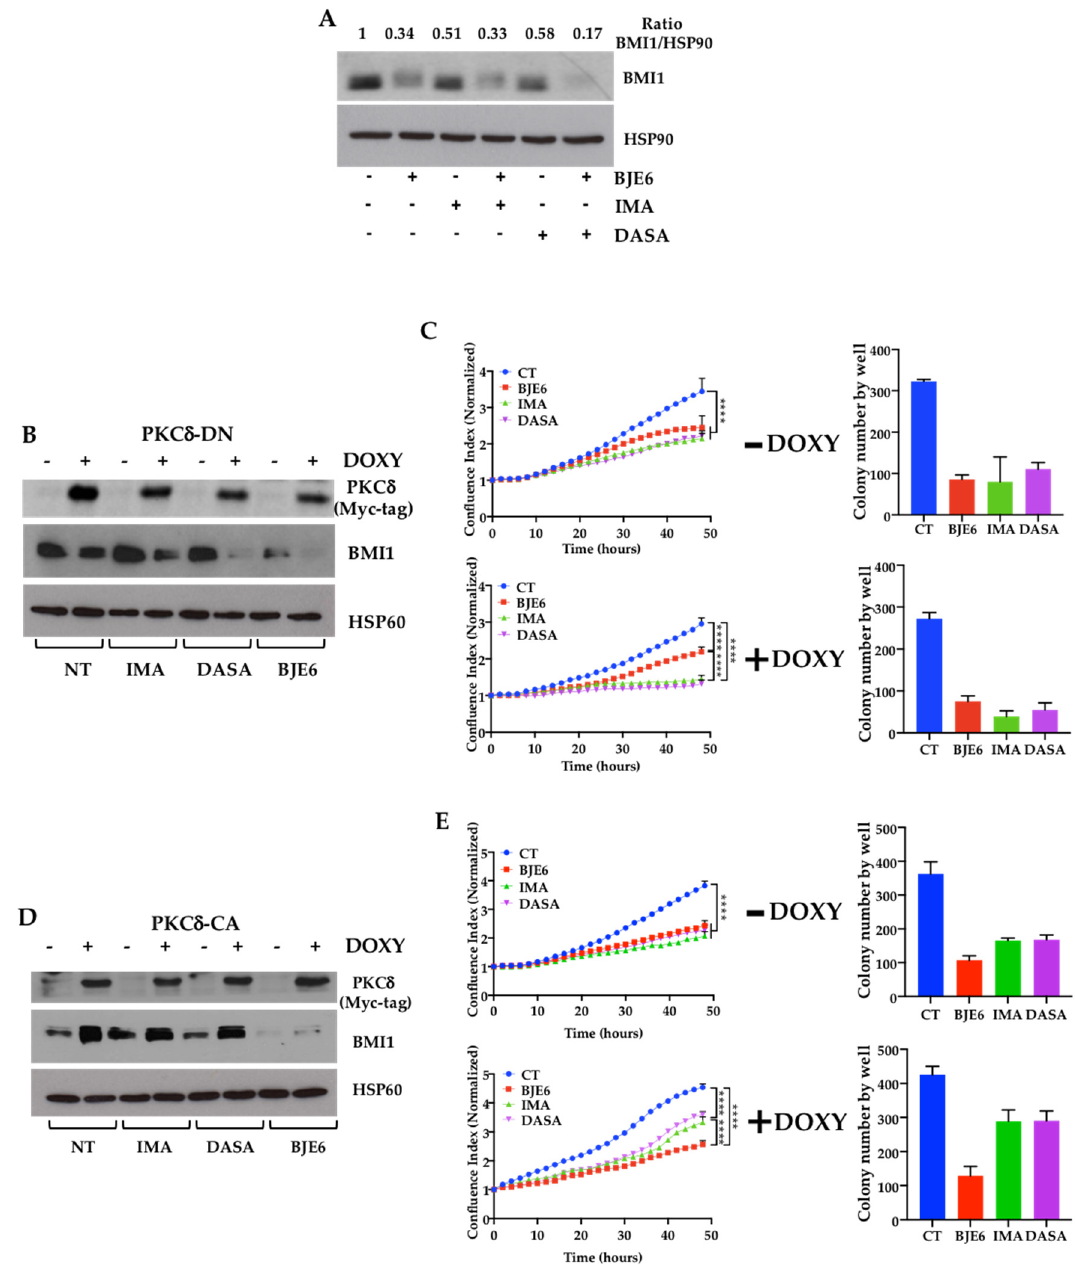
Figure 2. Expression of PKC δ correlated with BMI1 expression in CML cells and controlled proliferation and clonogenicity. ( A ) K562 cells were stimulated or not with BJE6 (0.5 µ M), IMA (1 µ M), DASA (2 nM), or a combination of BJE6 with any TKI. After 24 h, cell lysates were analyzed by BMI1 immunoblotting. ( B – E ) A1-K562 was stimulated with doxycycline (DOXY) (1 µ g/mL) for 2 days for induction of DN-PKC δ ( B , C ) or CA-PKC δ ( D , E ). Cell lysates were analyzed by BMI1 and myc-Tag immunoblotting ( B , D ). After DN-PKC δ and CA-PKC δ induction, cells were treated for 48 h (proliferation: ( C , E ) left panels) or 7 days (clonogenicity: ( C , E ) right panels) with DMSO (CT), 0.1 µ M BJE6, 1 µ M IMA, or 2 nM DASA. Time-lapse analysis of cells was performed with IncuCyte system. Graphs show quantification of cell numbers from phase-contrast confluence. Data represent mean ± SD ( n = 3). **** p < 0.0001, two-way ANOVA, Tukey’s multiple comparison. A.U., arbitrary